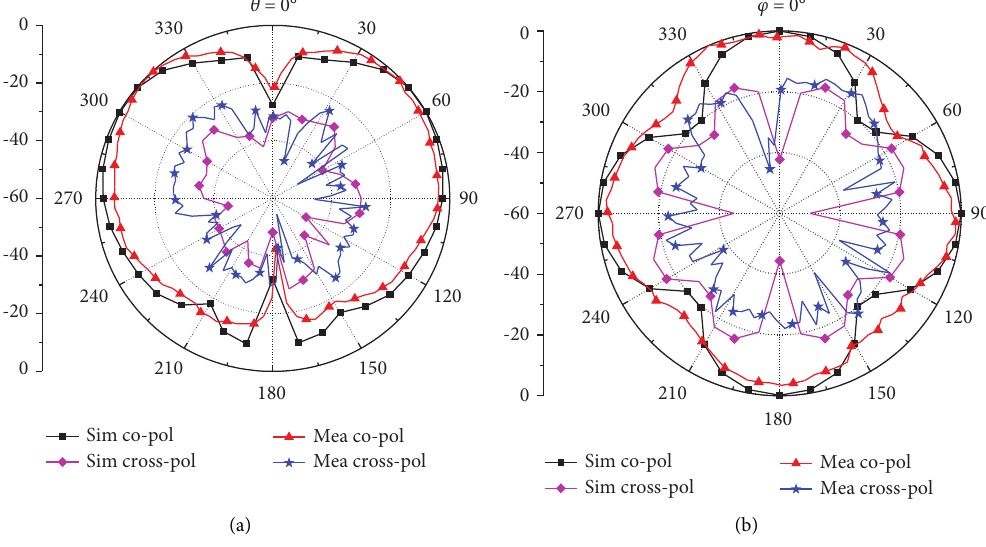
Figure 14: Simulated and measured radiation patterns at 6.8GHz. (a) φ � 0 ° ( x - z plane). (b) θ � 50 °